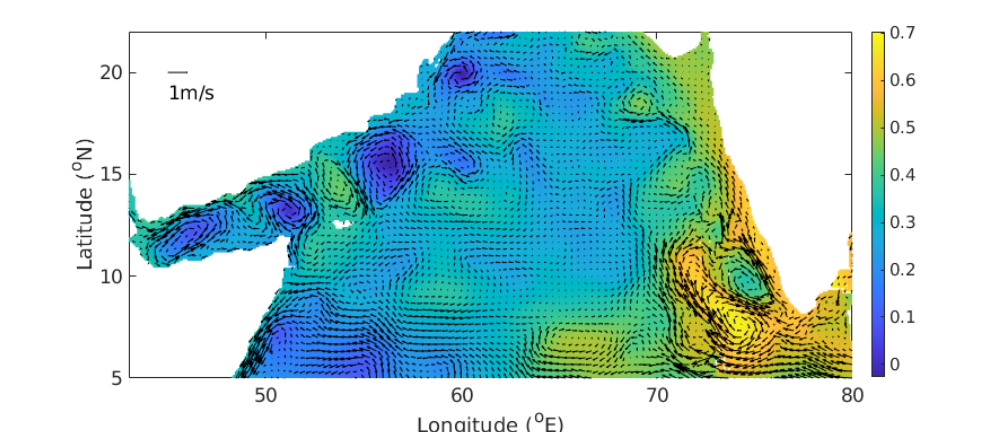
Figure 1. Plot illustrating the SSH and surface currents in the Arabian Sea at a snapshot representative of a typical day during the summer